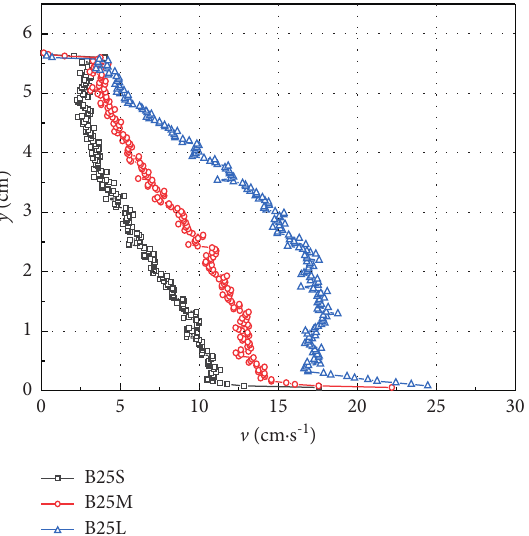
Figure 14: The vertical distribution of the vertical turbulent intensities in different working